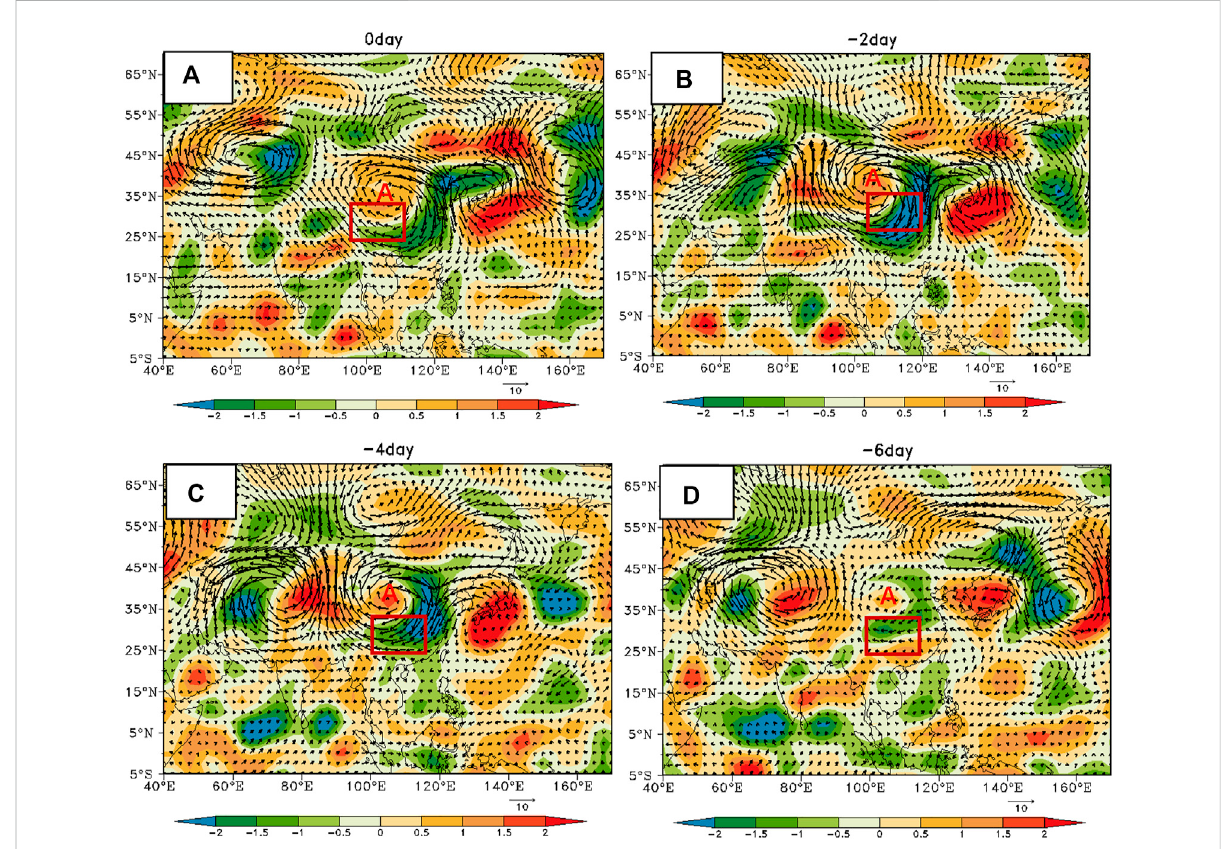
FIGURE 14 Evolutionofthelow-frequency(15 – 30 days)divergence(shading,unit:10 − 6 S − 1 )andwind(vector, unit:m/s) fi eldat200 hPafrom6 daysbefore the precipitation to 0 day after onset in East